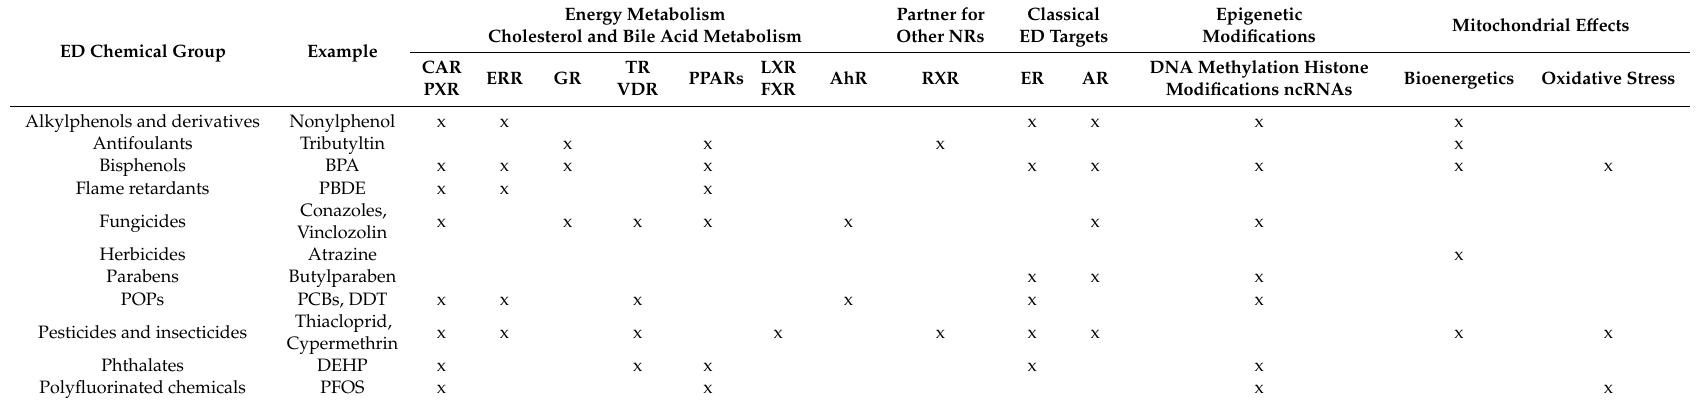
Table 1. Metabolism disrupting chemicals (MDCs), their nuclear receptors (NRs) and other transcription factor targets, epigenetic modifications, and mitochondrial e ff ects